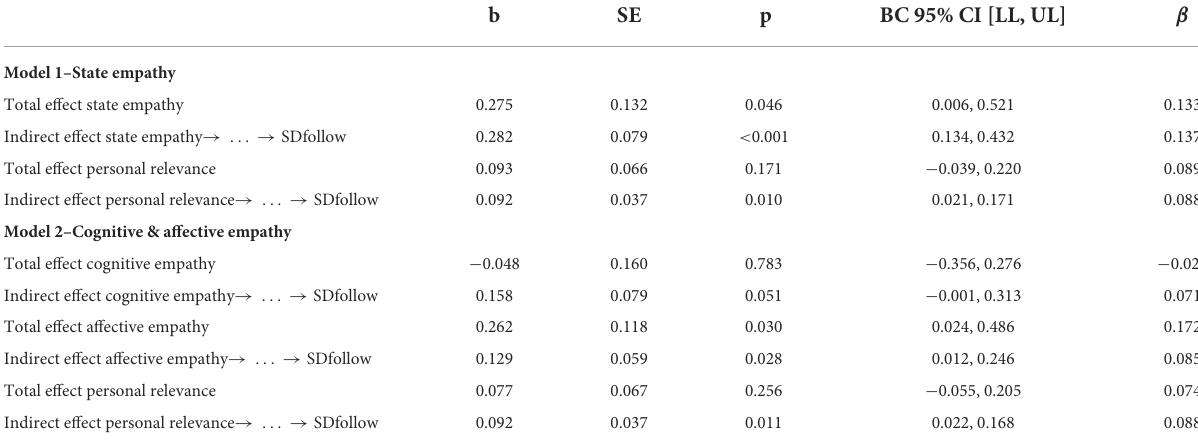
TABLE 4 Total and indirect effects of Model 1 and Model 2 path